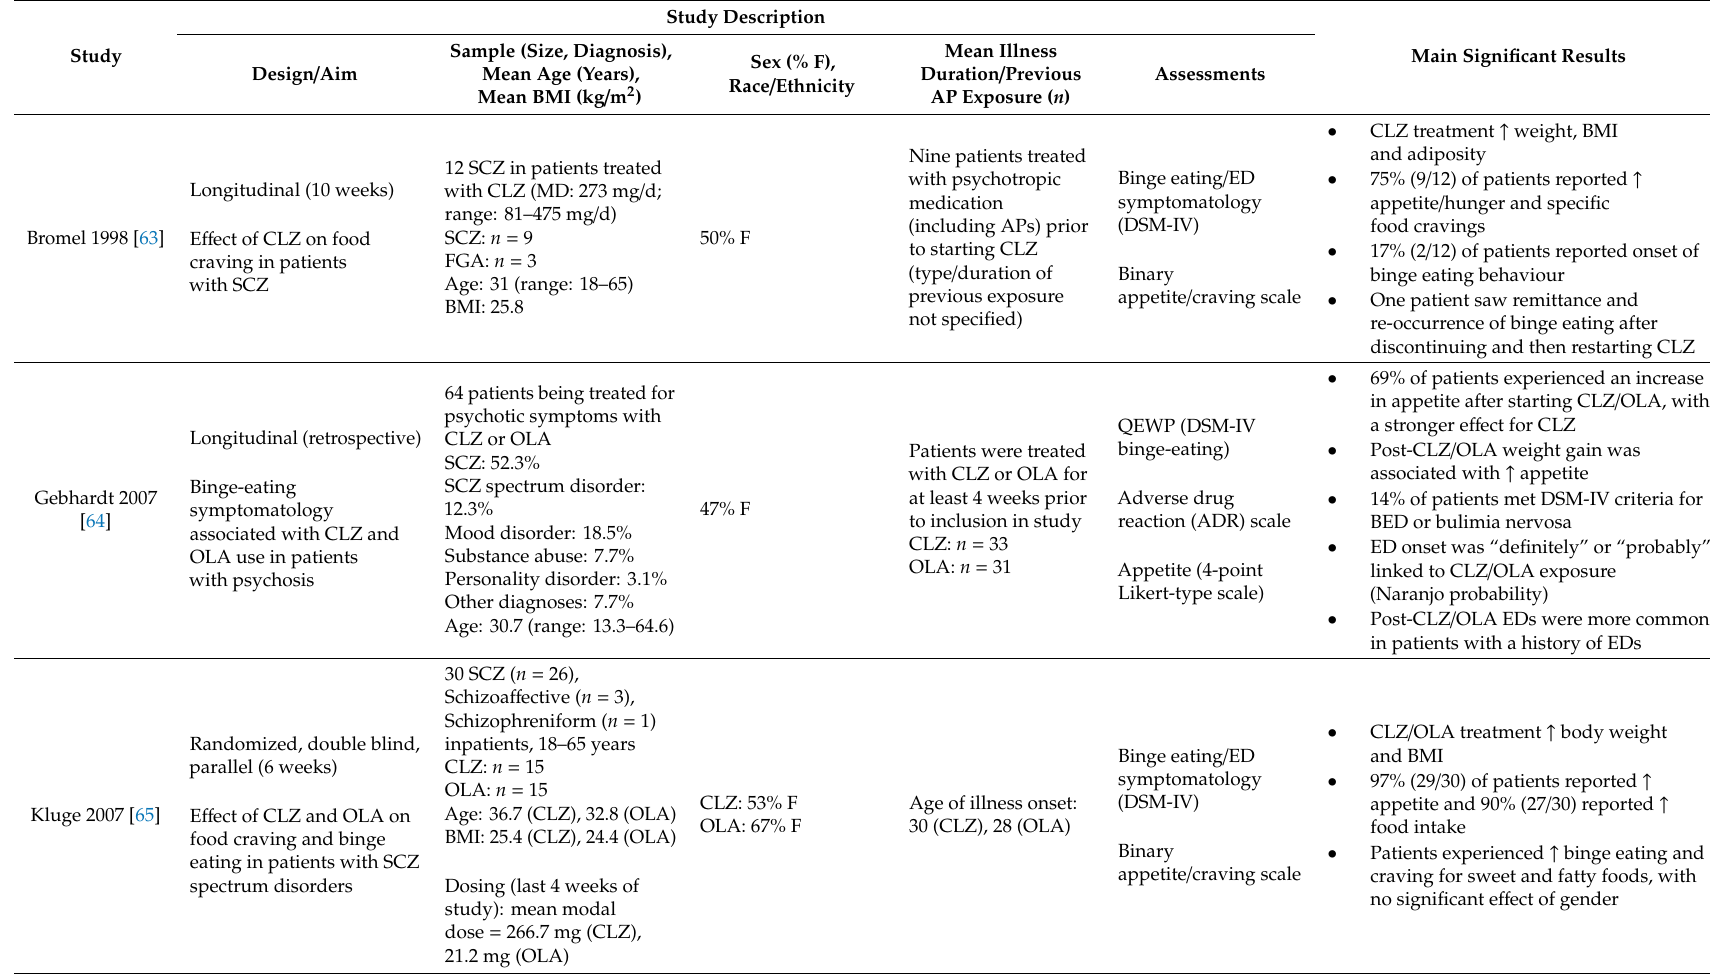
Table 5. Characteristics of studies reporting on subjective ratings of appetite, craving and